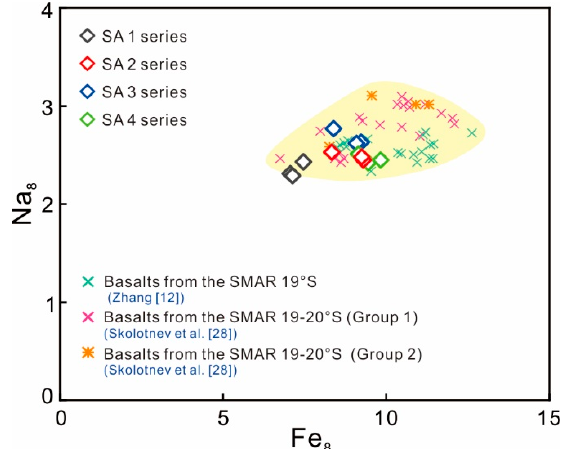
Figure 12. Plots of Fe 8 versus Na 8 of the SMAR basalt bulk rock samples. Data for basalts from the SMAR 19°–20°S are from [12,28].